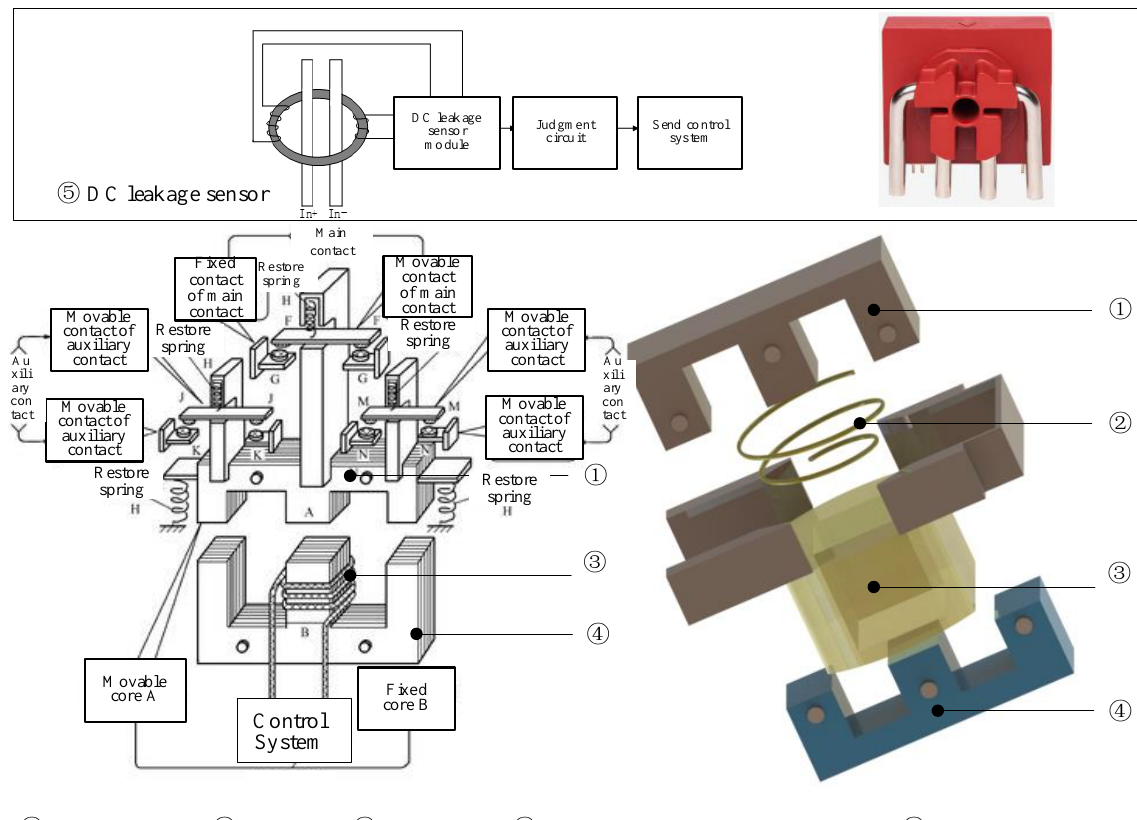
Figure 1. Main structure of the new DC leakage protector.